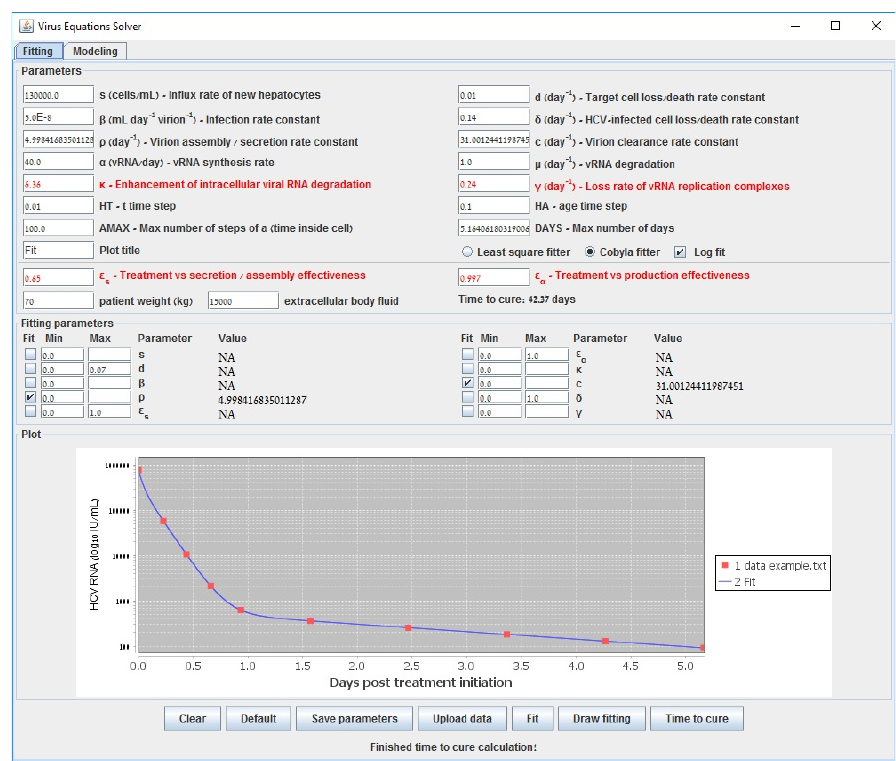
Figure A9. Fitting the parameters c and ρ of the multiscale model to generated data points using the COBYLA